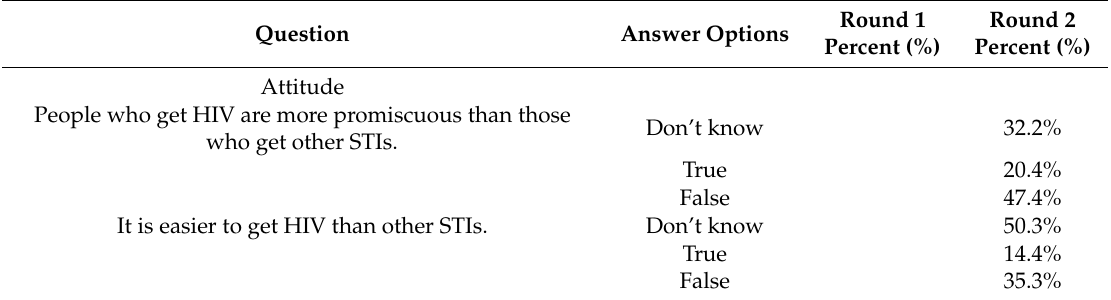
Table 2. HIV-related attitude among college students (n =